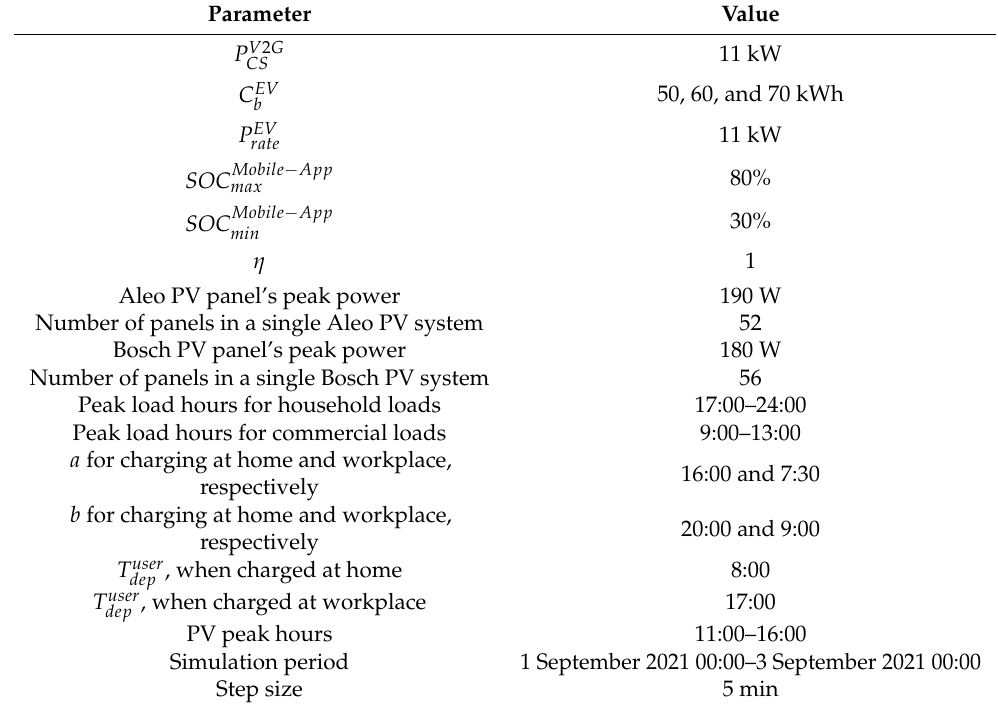
Table 1. Simulation parameter